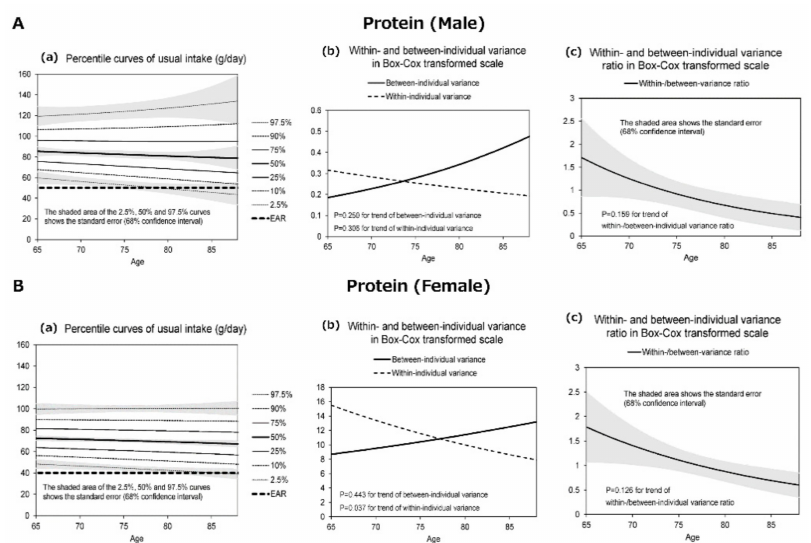
Figure 1. The percentile curves of usual nutrient intake of protein by age (male and